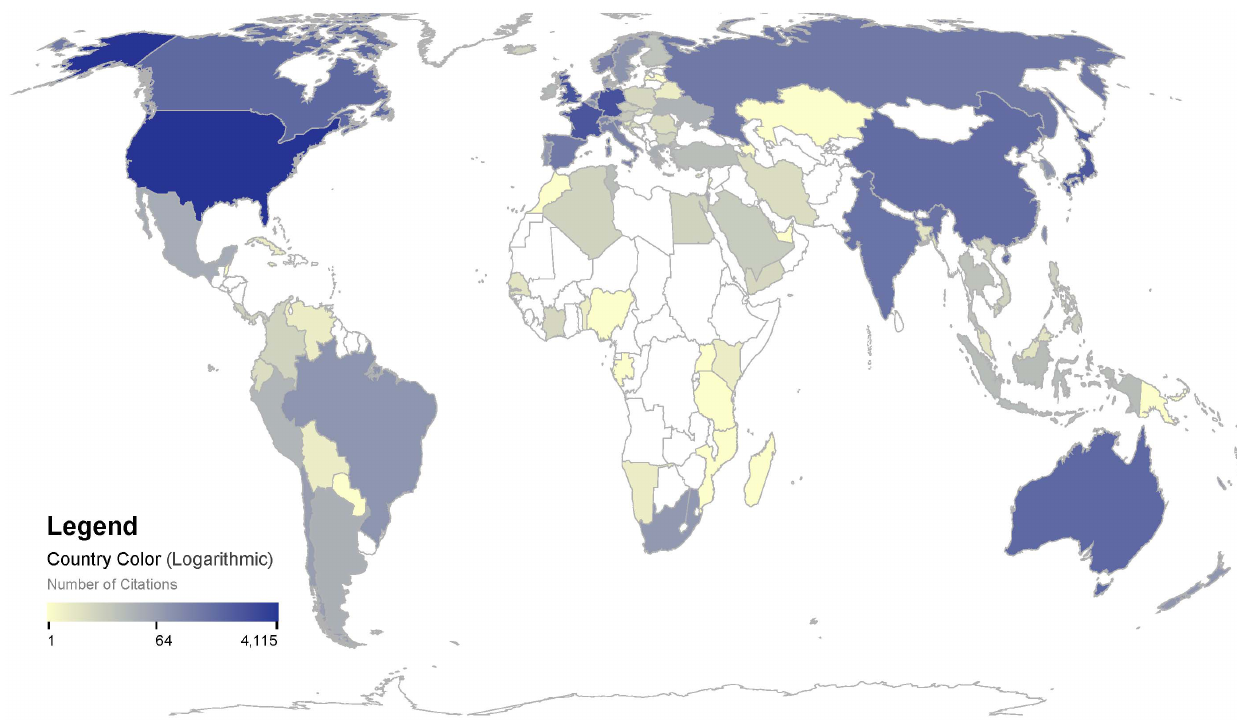
Figure 4. Number of articles citing all versions of the WOA/WOD per country.